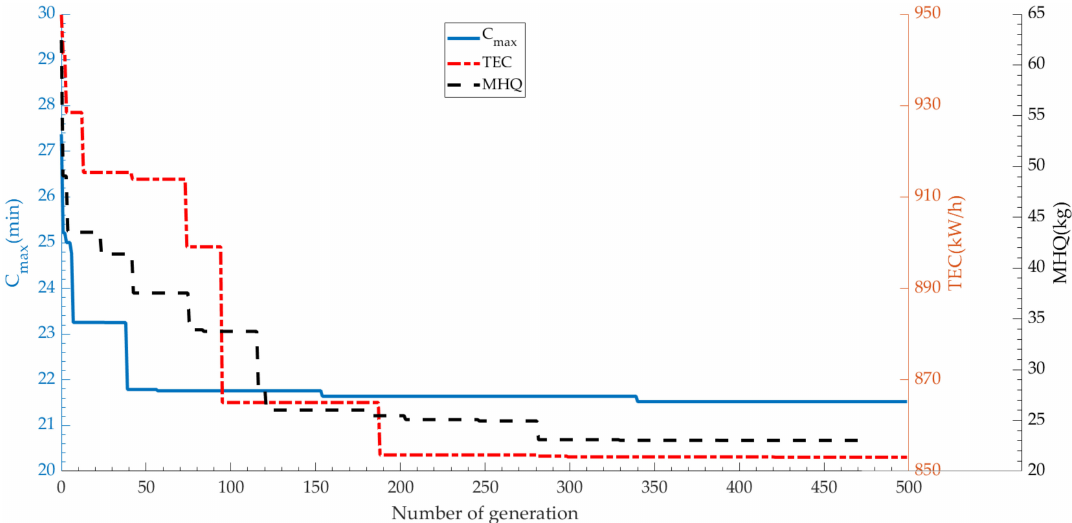
Figure 12. The convergence curve of three objective